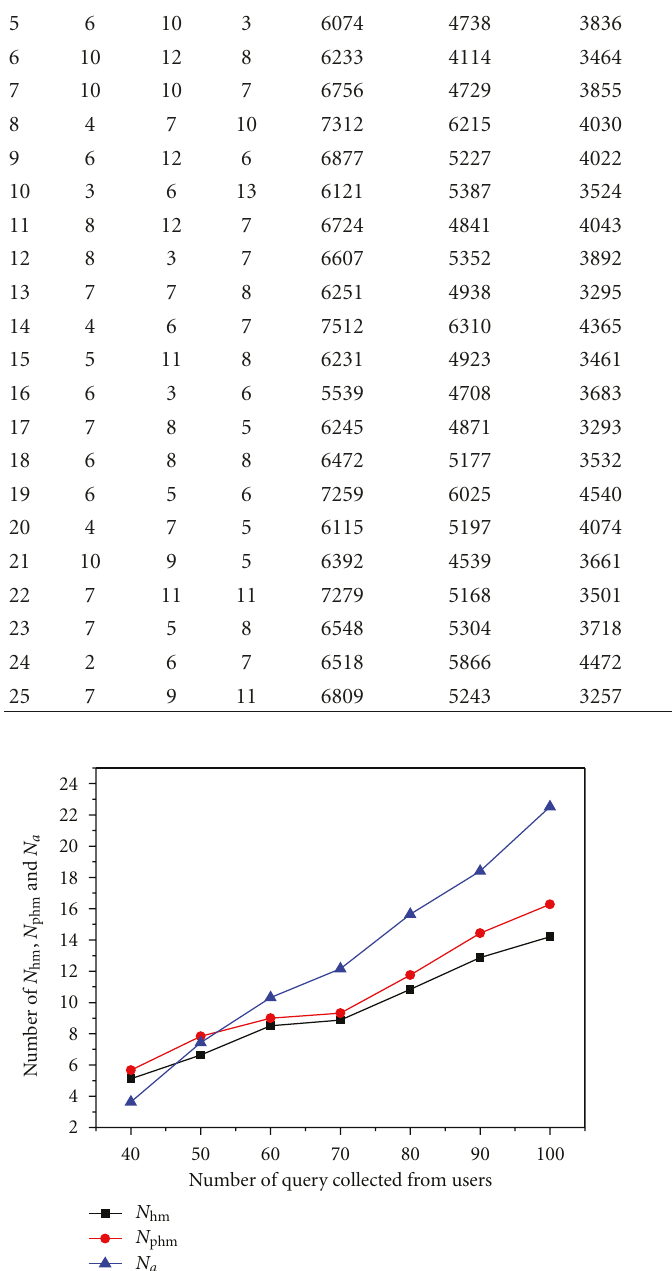
Figure 7: Energy sensitivity of total